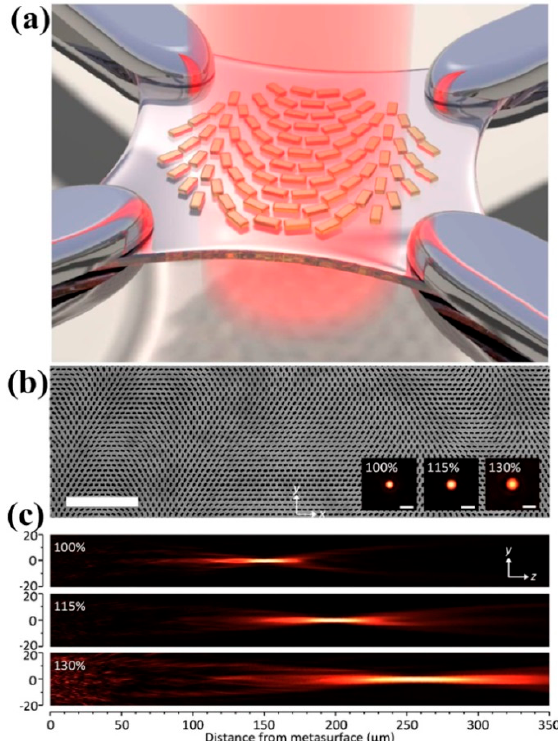
Figure 6. ( a ) Schematic illustration of a metalens array on a stretchable substrate and ( b ) SEM image of the metalens array fabricated by EBL and stripping. ( c ) Measured longitudinal beam profiles generated on the transmission side of the flat zoom lens with di ff erent stretch ratios (100%, 115%, and 130%). Note that the metasurface is located at the position of z = 0. Reproduced with permission from [127]. Copyright American Chemical Society, 2016.